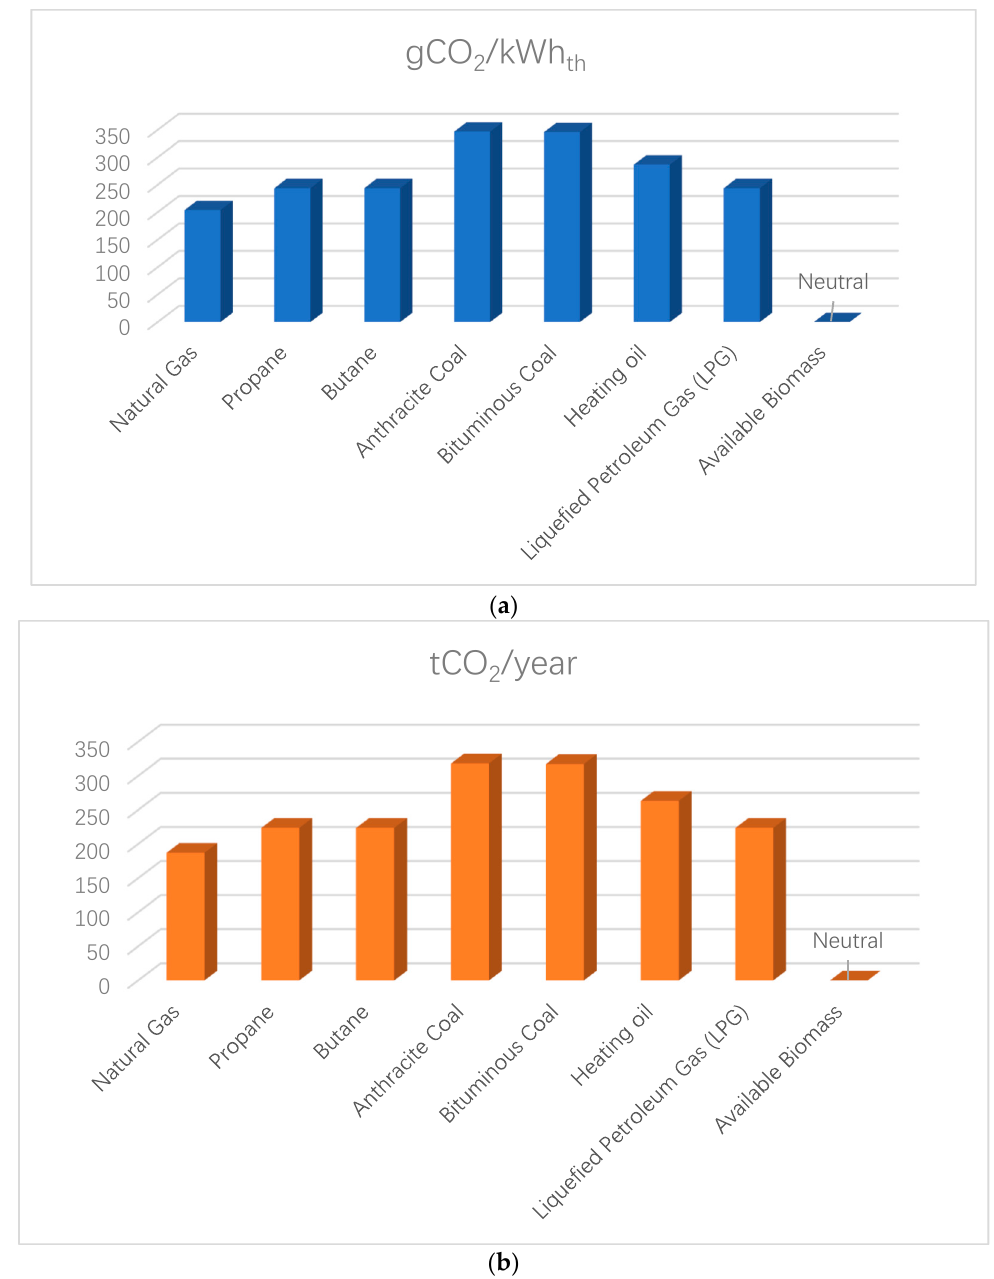
Figure 1. Comparison of CO 2 emissions by fuel type in energy applications: ( a ) emission of CO 2 per kWh th produced, ( b ) tones of CO 2 produced with each type of